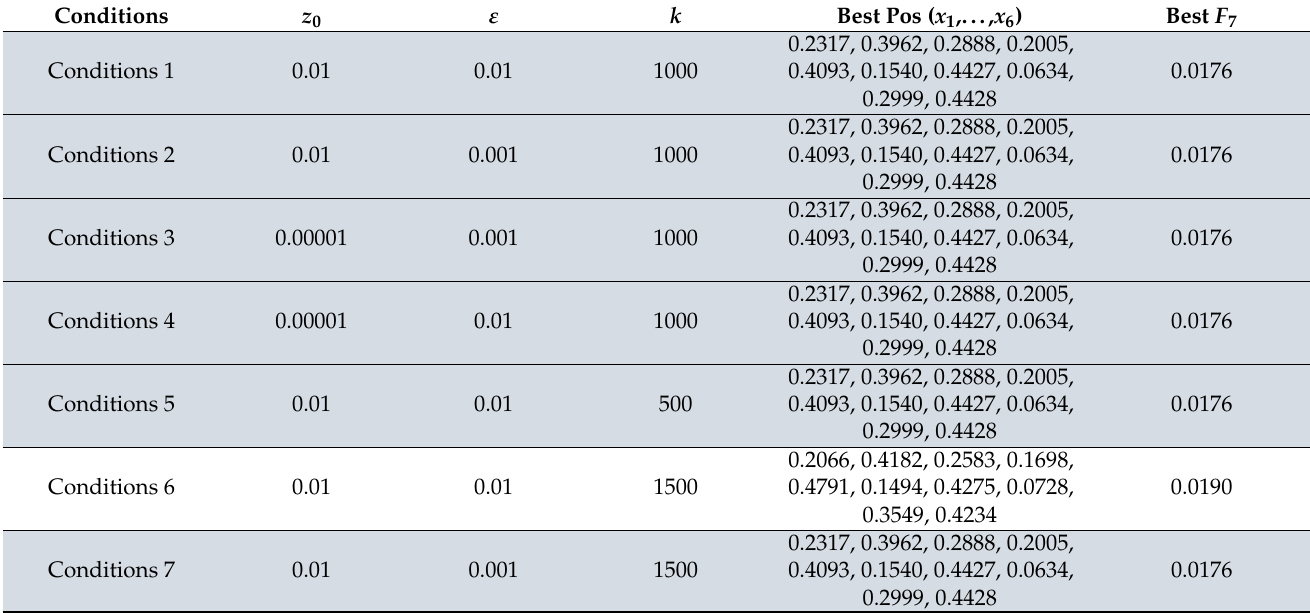
Table 10. Results of Case 7: F 7 at different